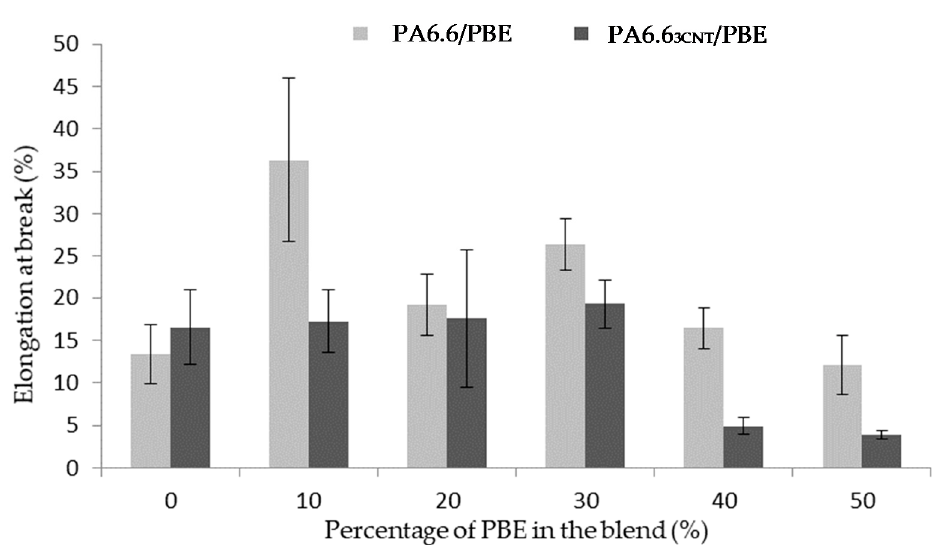
Figure 5. Influence of the proportion by weight of PBE on the mechanical properties of the PA6.6 3CNT /PBE blends.